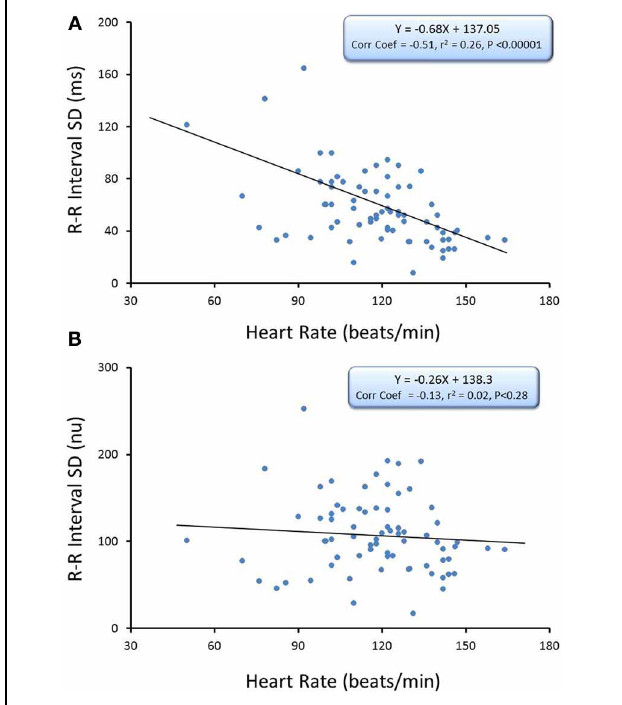
FIGURE 2 | The relationship between baseline heart rate and heart rate variability. The total heart rate (HR) variability (standard deviation of R-R interval, RRSD) was calculated for over the last 30s before an autonomic intervention was administered and plotted against the average HR for that interval. One data point is displayed for each animal ( n = 74). The data without and with HR correction (RRSD/mean RR) are displayed in ( A,B) , respectively. Note that HR only accounted for less than 30% ( r 2 = 0 . 26) of the variability before correction for HR. nu, normalized units following HR